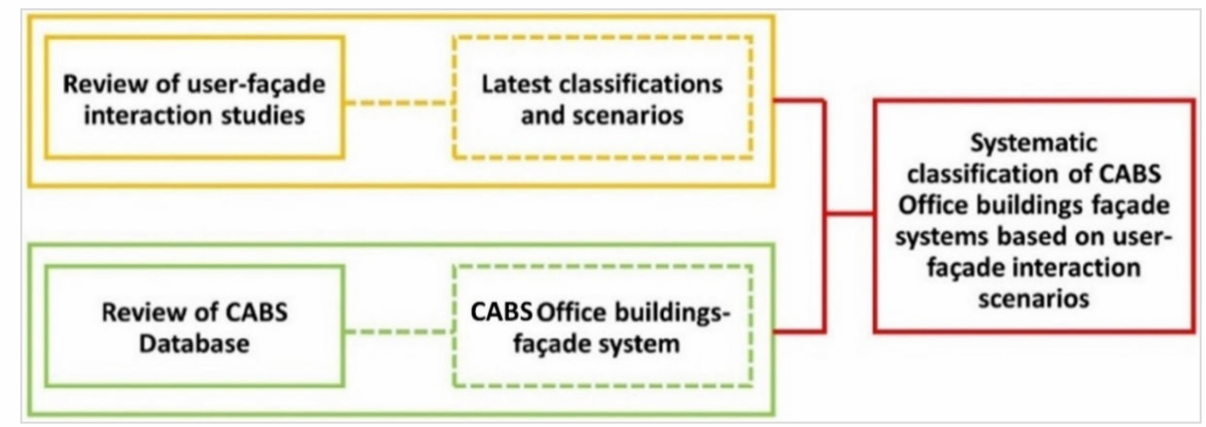
Figure 2. PRISMA methodology results (Authors, 2022).